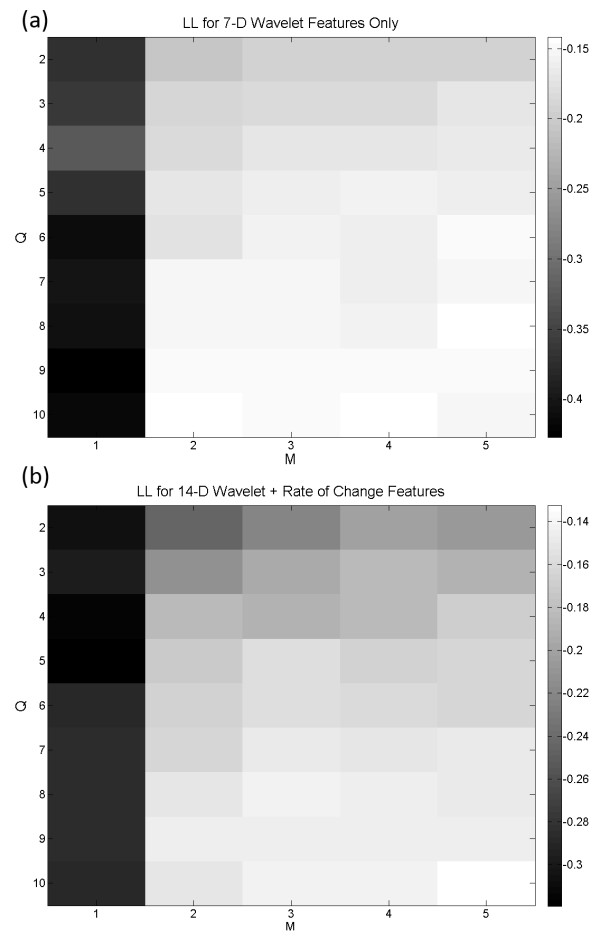
Log-likelihoods of HMMs. (a) The LL for the HMM using wavelet coefficient features is shown. The LL increases as Q and M goes up. (b) The LL for the HMM using both wavelet and rate of change features. For any particular Q and M combination, the LL in this model is always larger than Figure 3a.